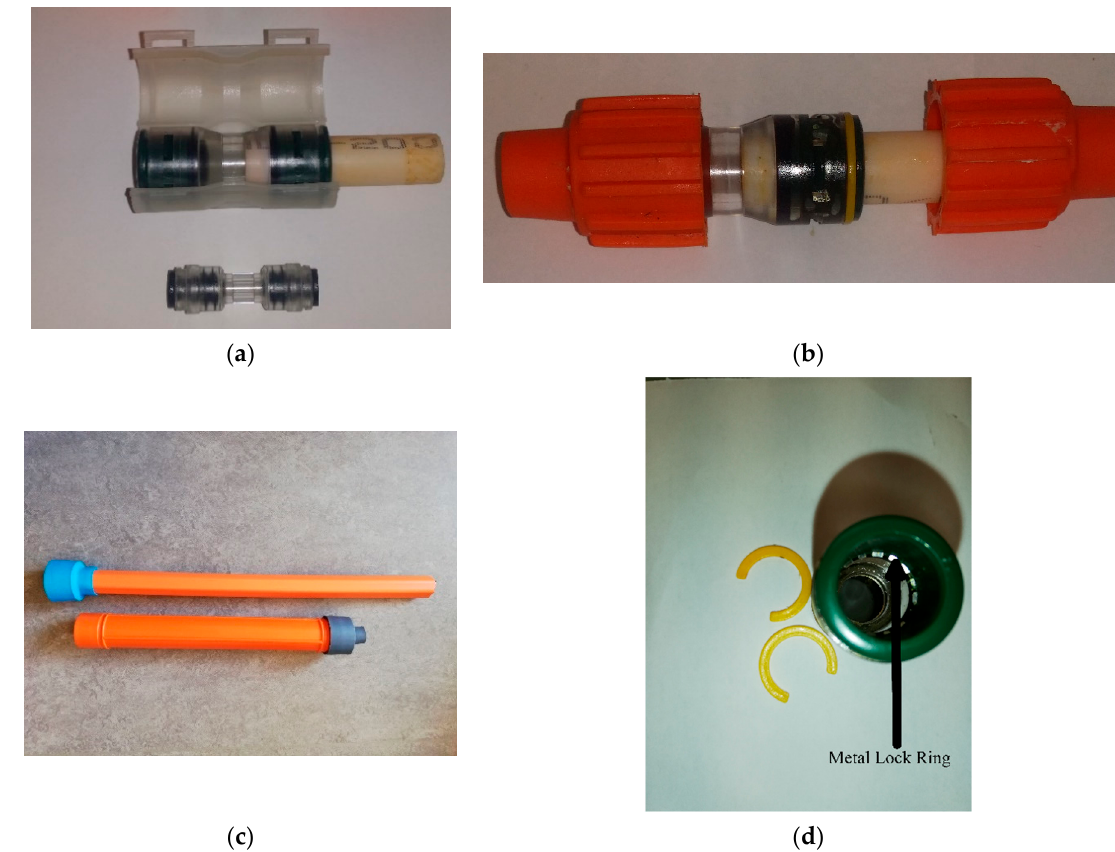
Figure 1. Mechanical joint types: ( a ) With and without lock; ( b ) With IP68 water protection jacket; ( c ) Straight duct for multiduct installation; ( d ) Outer plastic lock ring and inner metallic lock ring.